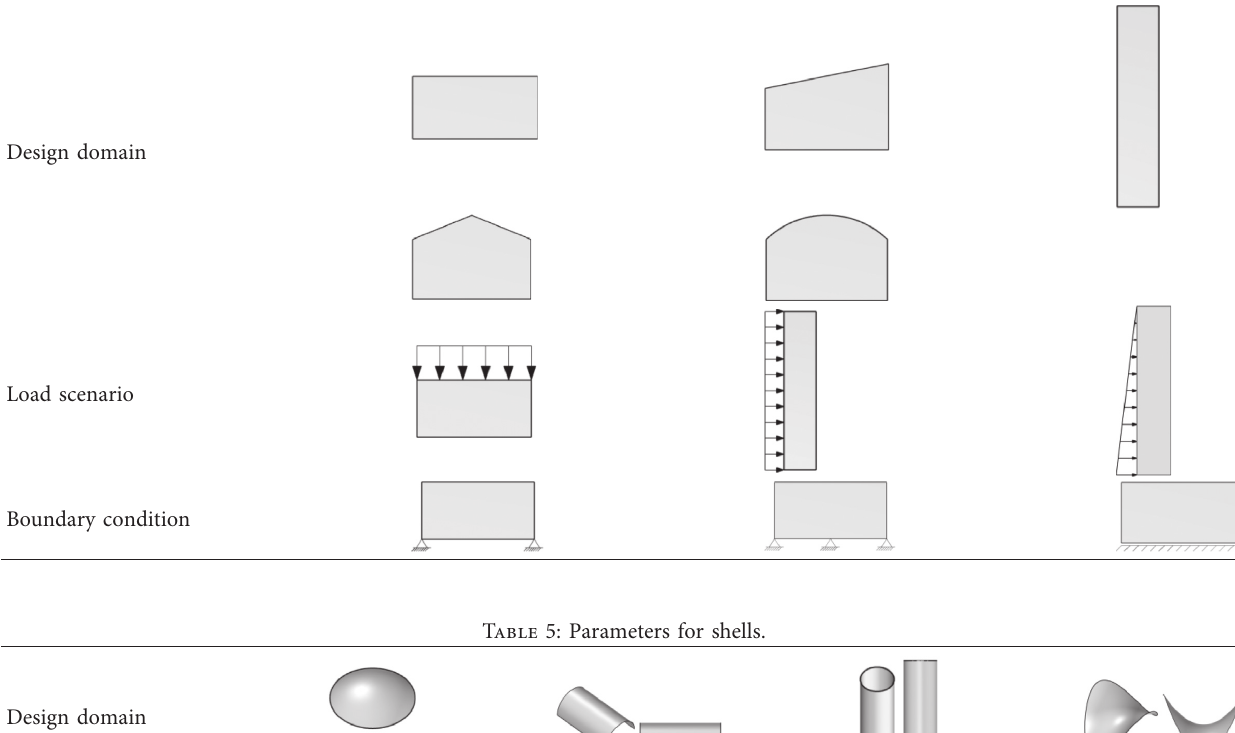
Table 4: Parameters for walls.